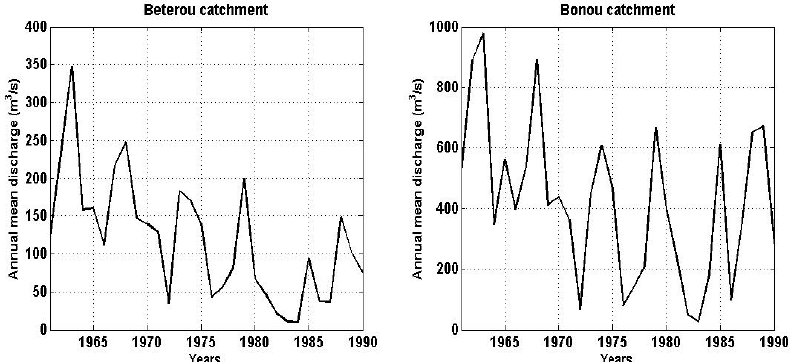
Figure 7. Annual mean of river discharge in Bétérou ( left ) and Bonou ( right ) catchments.